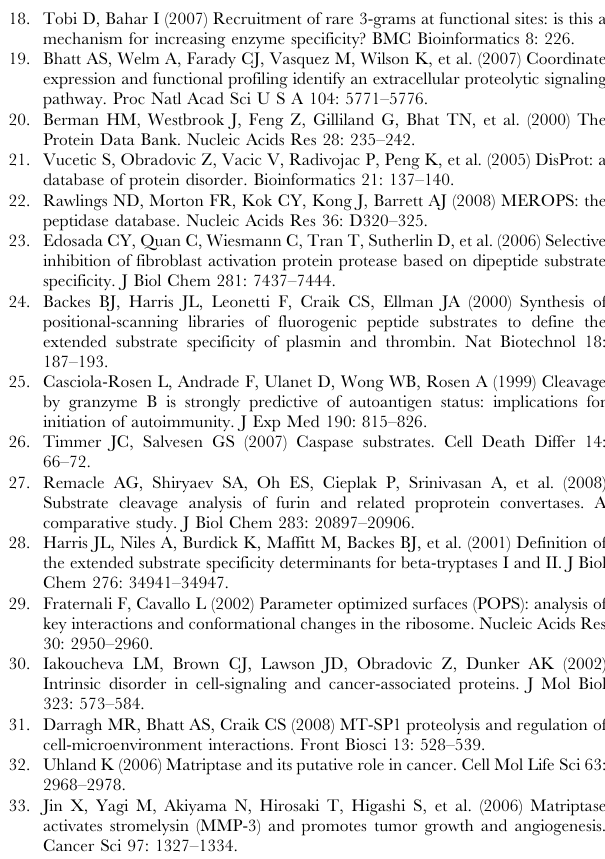
Table S4 Putative Substrates of Human Proteome Queried with